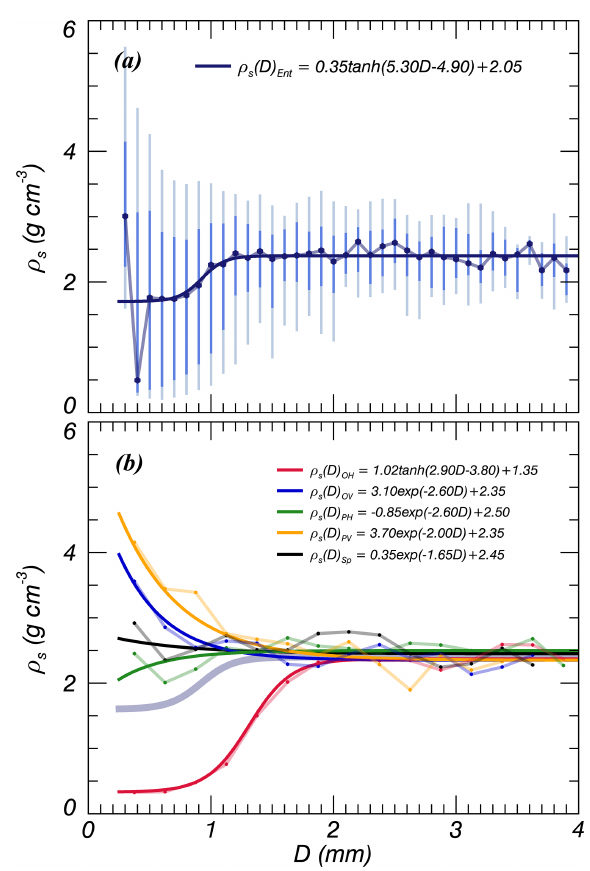
Figure 10. Same as Fig. 9 but for particle density ( ρ s